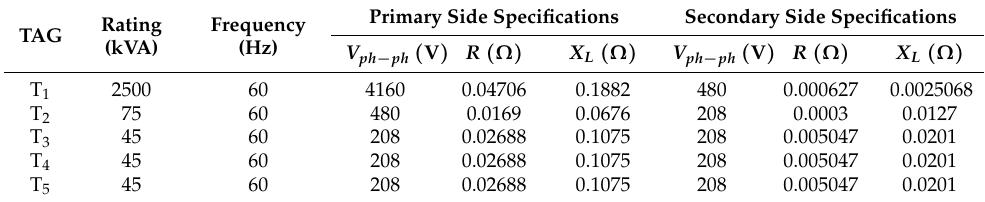
Table A2. Specifications of microgrid testbench transformers.